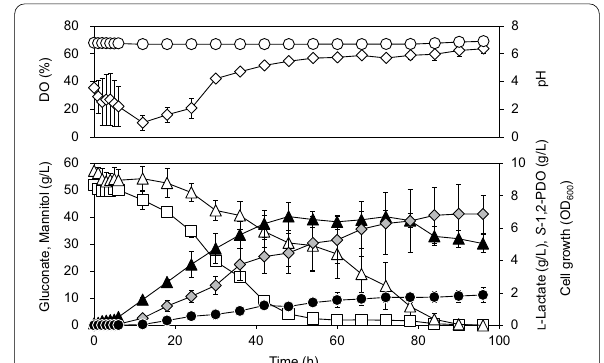
Fig. 5 Production of 1,2-PDO in L. lactis LL1 from 5% mannitol and 5% gluconate in a jar fermenter controlled with a pH–stat. L. lactis LL1 was cultivated for 96 h at 30 °C in M17 medium supplemented with 5% mannitol and 5% gluconate under microaerobic conditions. The medium was supplemented with 0.3 g/L acetate. The pH of the culture was maintained at 6.8 by addition of 2 M NaOH during cultivation. Closed triangles, cell growth (OD 600 ); closed circles, S -1,2-PDO; shaded diamonds, L-lactate; open triangles, mannitol; open squares, gluconate; open diamonds, concentration of DO in the culture; open circles, pH of the culture. This experiment was performed in duplicate, and the average is represented with error